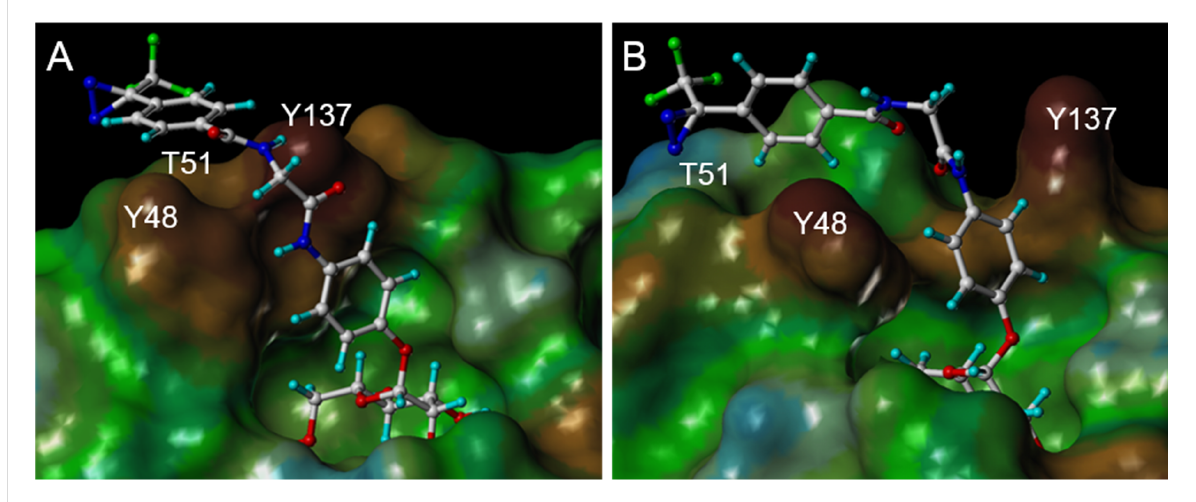
Figure 4: Connolly representation of photolabile α -D-mannoside 3 in the closed gate (A, PDB code 1UWF) and open gate crystal structure of FimH (B, PDB code 1KLF) [24]. The surface is colored according to the lipophilic potential, where brown reflects more hydrophobic and blue more hydro- philic amino acid residues [25]. Amino acid residues Y48 and Y137, forming the “tyrosine gate” are highlighted as well as T51, which is a good candi- date for photolabeling.